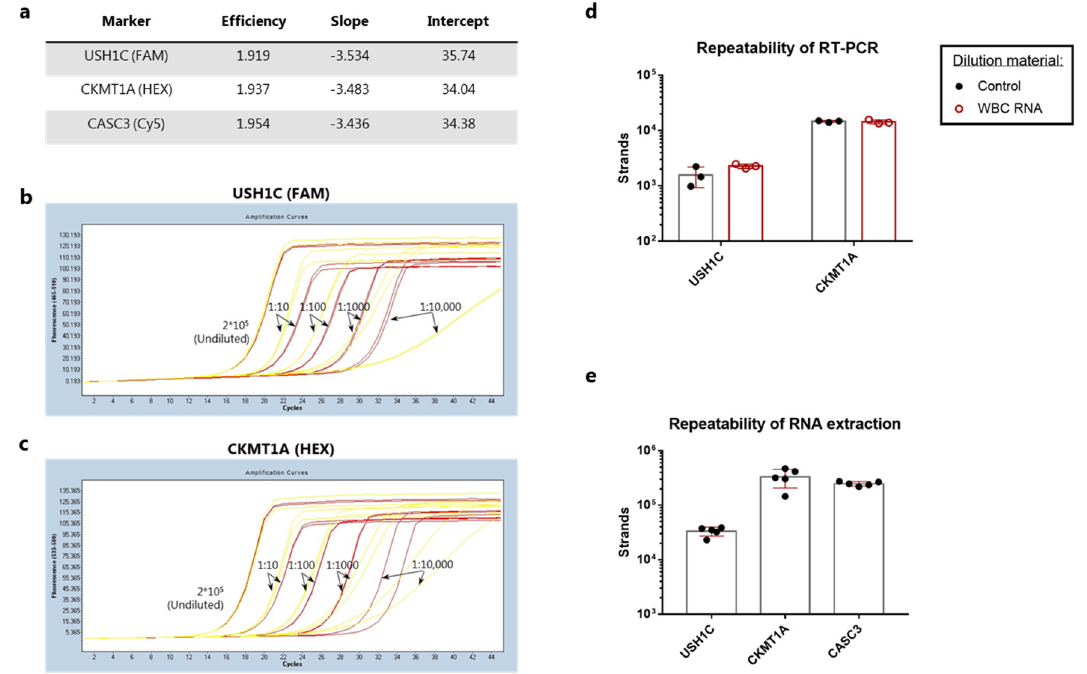
Figure 3. Analytical validation of the qPCR, RT-PCR and RNA extraction procedure. ( a ) qPCR assay performance on linearized calibrator sequences. A standard curve was generated from duplicate samples containing 20–200,000 strands per reaction (10-fold dilutions) and analyzed in the LightCycler ® software by plotting Cp values as a function of log(conc). For each primer pair the efficiency of amplification, the slope of the standard curve as well as the intercept at log(1 strand) is shown in the table. ( b ) Calibrator dilutions using either TE buffer with carrier RNA (red curves) or cDNA generated from WBCs (yellow curves). Calibrators were detected with the USH1C primers. ( c ) Same as in ( b ), but with detection using the CKMT1A primers. ( d ) Triplicate samples of 0.1 ng pre-purified human colon RNA diluted in buffer (control, black circles and bars) or WBC RNA (red circles and bars) prior to RT-PCR. ( e ) RNA purification from five samples containing 1000 COLO205 mixed with 50,000 white blood cells using separate QIAamp spin columns. Bars represent the mean strand count and error bars show standard deviation in ( d , e ).